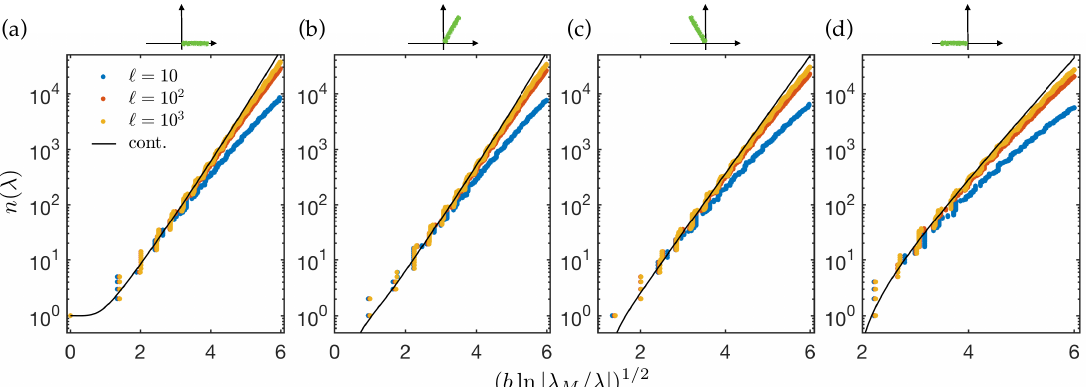
Figure 4: Spectrum of eigenvalues of ρ T A with a certain complex phase (c.f. Fig. 3(a)) for two equal intervals on an infinite chain. Solid lines are the prediction in Eq. (76b). Dots are numerics, with different colors corresponding to different subsystem